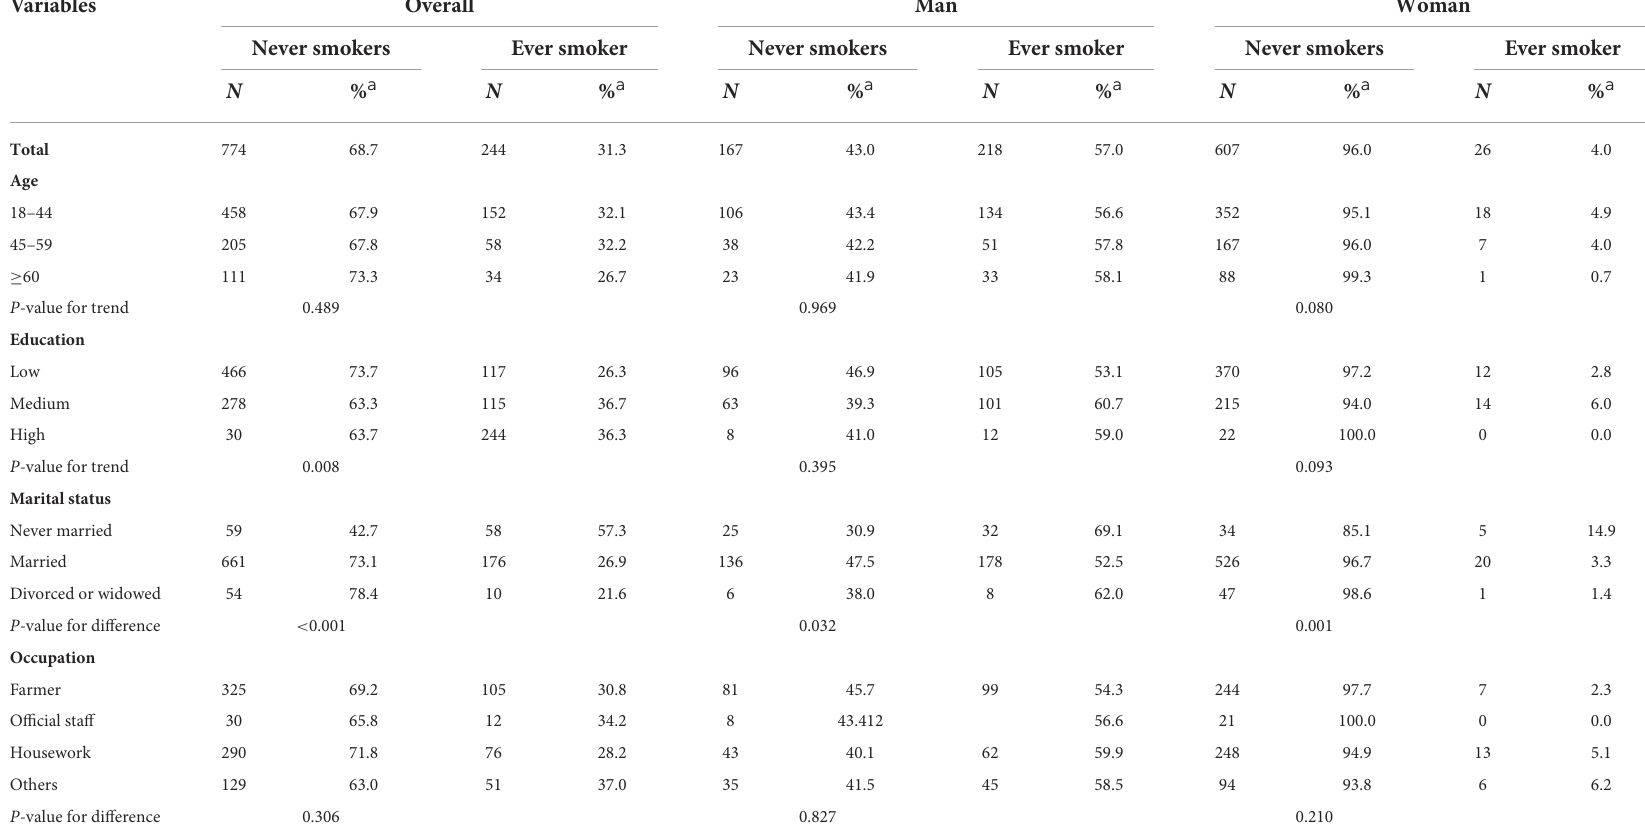
TABLE 2 Prevalence of cigarette smoking of the participants by demographic